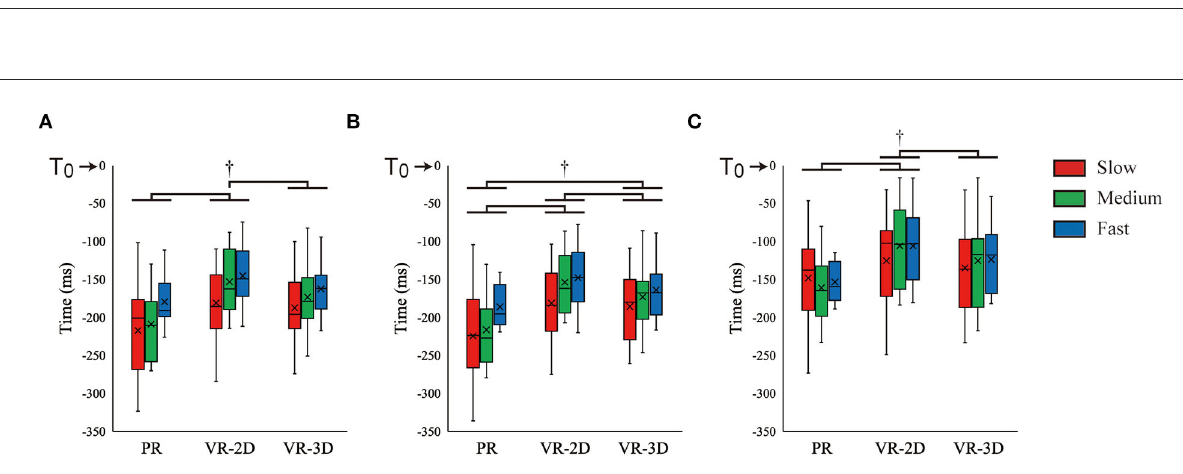
FIGURE8 Box plot of the EMG onsets of anterior deltoid [T AD ; (A) ], biceps brachii [T BB ; (B) ], and flexor carpi radialis [T FCR ; (C) ] muscles. The dagger (†) indicates the significant pairwise differences ( p < 0.05) after a significant main effect of environment was